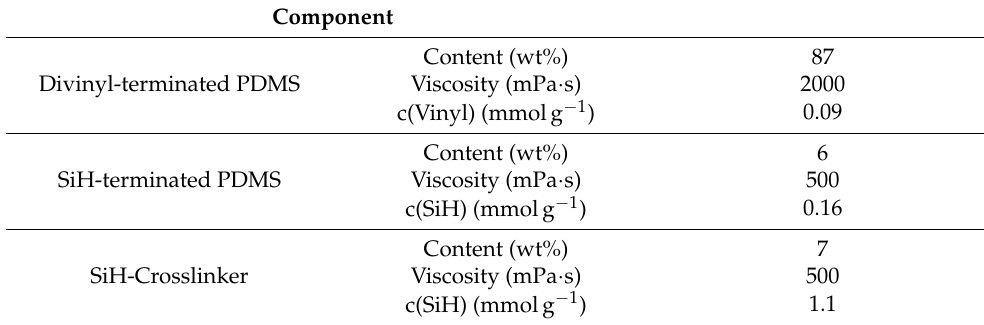
Table 1. Silicone formulation S2